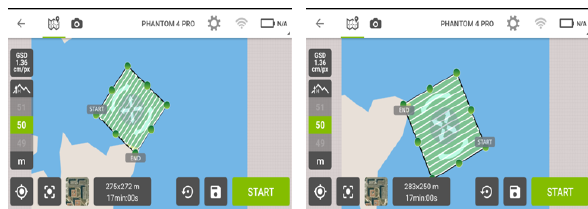
Figure 2: Flight plans 1 and 2 for the north eastern part of Santiago